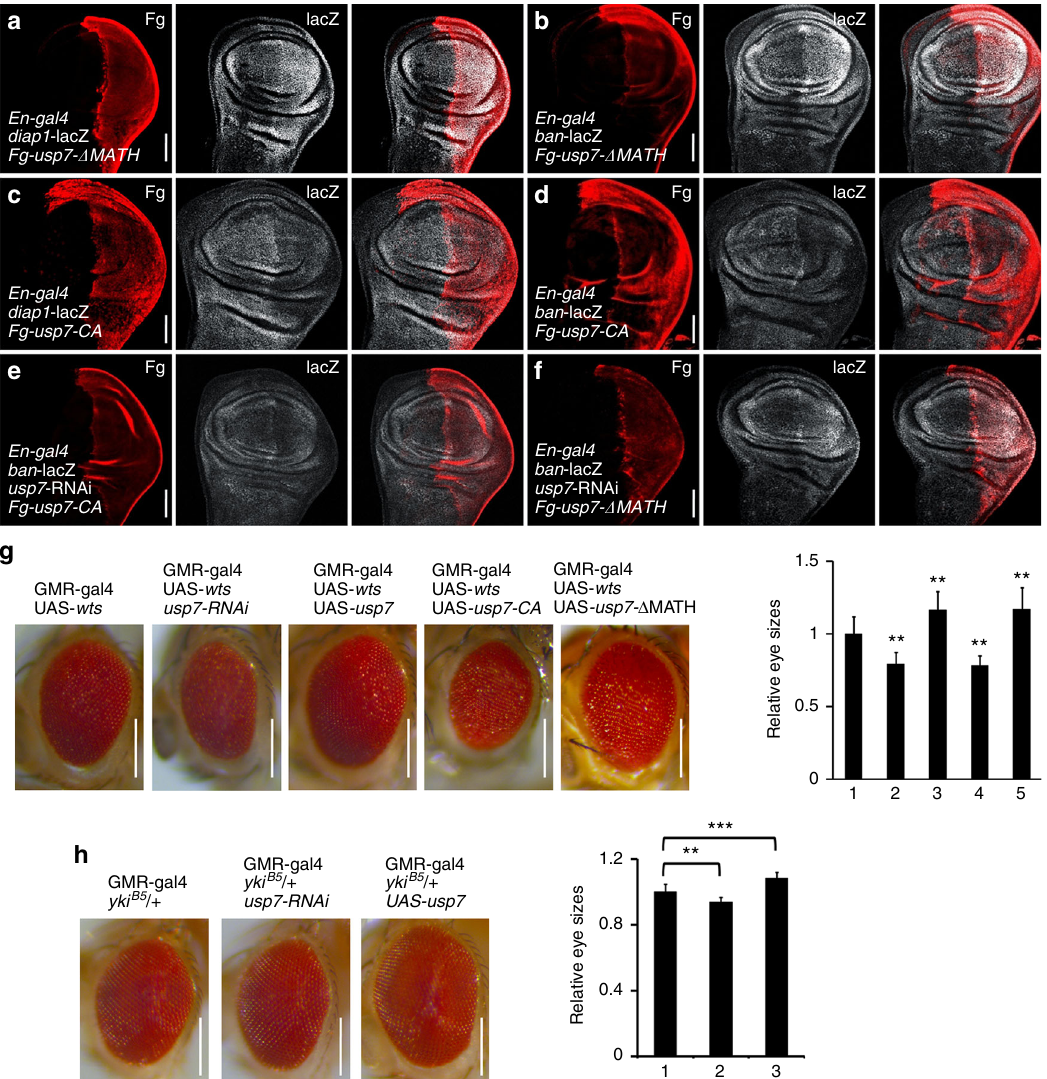
Fig. 4 Usp7 regulates Hippo (Hpo) pathway though its deubiquitinase activity. a , b Wing discs expressing Fg-tagged usp7- Δ MATH were stained to show Fg tag (red) and diap1 -lacZ (white in a ) or ban -lacZ (white in b ). Of note, overexpression of usp7- Δ MATH increased diap1 -lacZ and ban -lacZ. c , d Wing discs expressing Fg- usp7-CA were stained to show Fg tag (red) and diap1 -lacZ (white in c ) or ban -lacZ (white in d ). Of note, overexpression of usp7-CA decreased diap1 -lacZ and ban -lacZ. e A wing disc simultaneous expressing usp7 RNA interference (RNAi) and Fg- usp7-CA was immunostained to show Fg (red) and ban -lacZ (white). Overexpression of Fg- usp7-CA could not restored the decreased ban -lacZ caused by usp7 knockdown. f Overexpression of Fg- usp7- Δ MATH effectively rescued the attenuation of ban -lacZ induced by usp7 knockdown. g Comparison of adult eye sizes from control fl ies ( g -1), usp7 knockdown ( g -2), usp7 overexpression ( g -3), usp7-CA overexpression ( g -4), and usp7- Δ MATH expression ( g -5). Of note, knockdown of usp7 decreased eye size, whereas overexpression of usp7 or usp7- Δ MATH increased eye size. Overexpression of usp7-CA resulted in small eyes. Quanti fi cation analyses of the adult eyes were shown on right. h Comparison of adult eye sizes from control fl ies ( h -1), usp7 knockdown ( h -2), usp7 overexpression ( h -3). Quanti fi cation analyses of the adult eyes were shown on right. Data are means ± SEM. n = 10 biological-independent eyes. ** P < 0.01 and *** P < 0.001 by Student ’ s t -test. Scale bars: 50 μ m for all wing discs ( a - f ), whereas 200 μ m for all images ( g , h